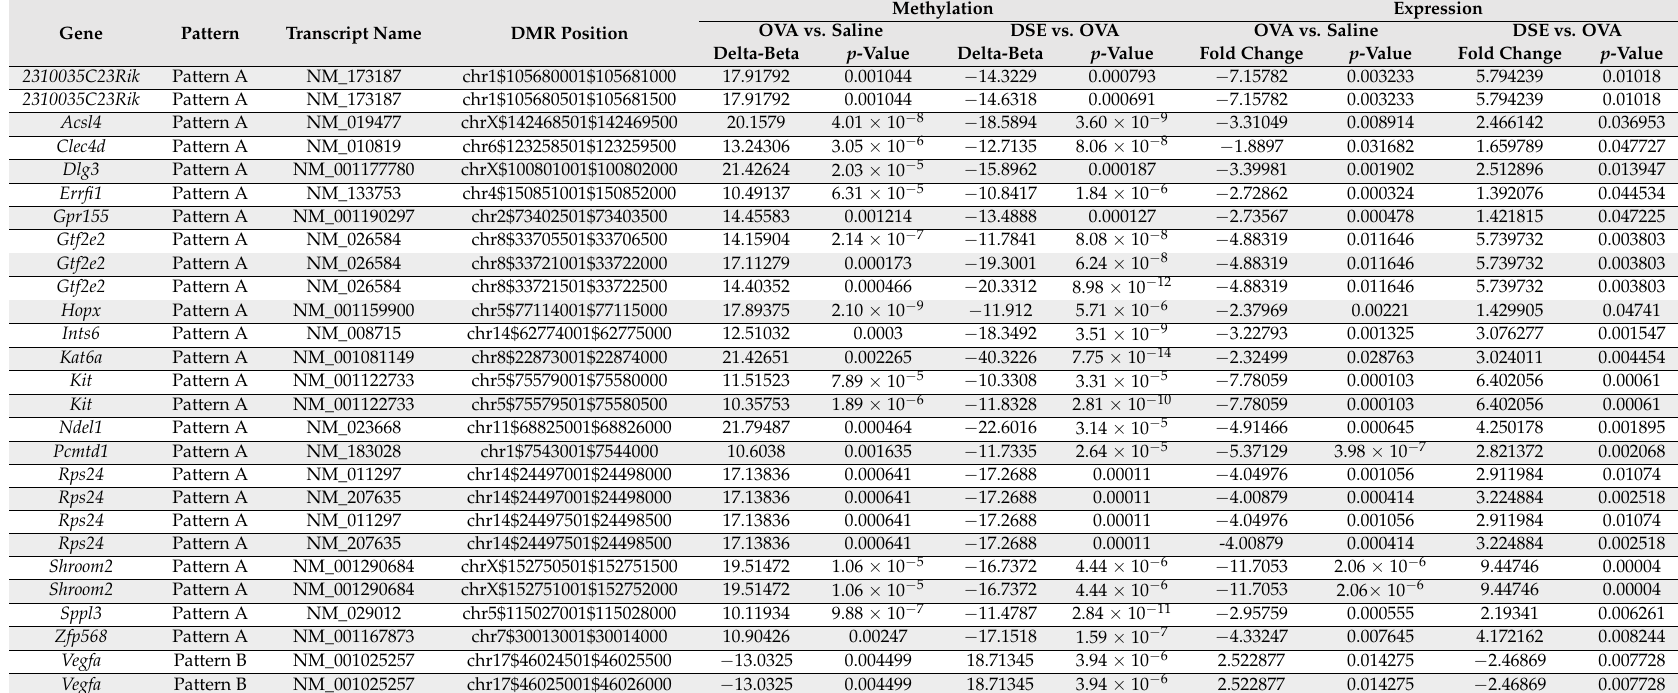
Table 1. Candidate genes of integrative pattern